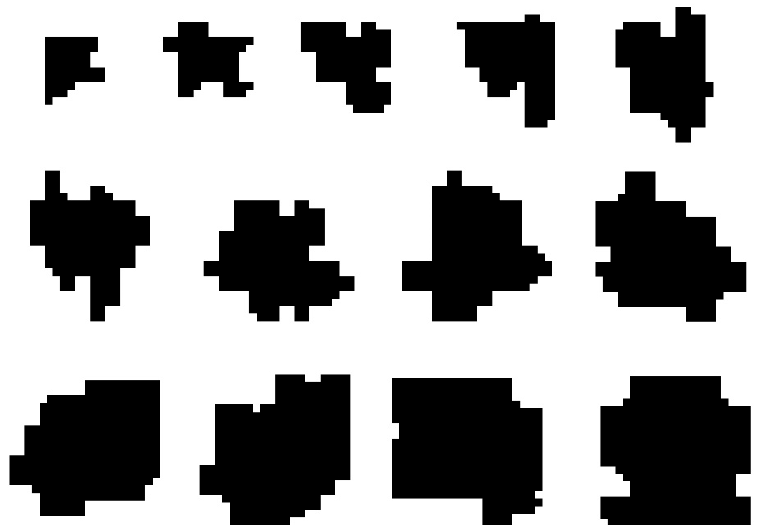
Figure 7. Examples of random shapes of buildings generated by our method. Buildings in this example have their floor plan area from 50 square meters (first) to 350 square meters (last).